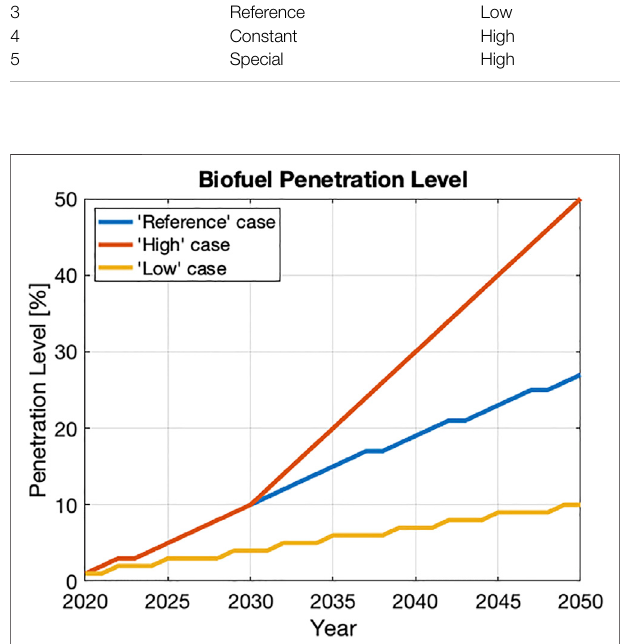
FIGURE 1 | Different biofuel penetration level cases considered in this study.